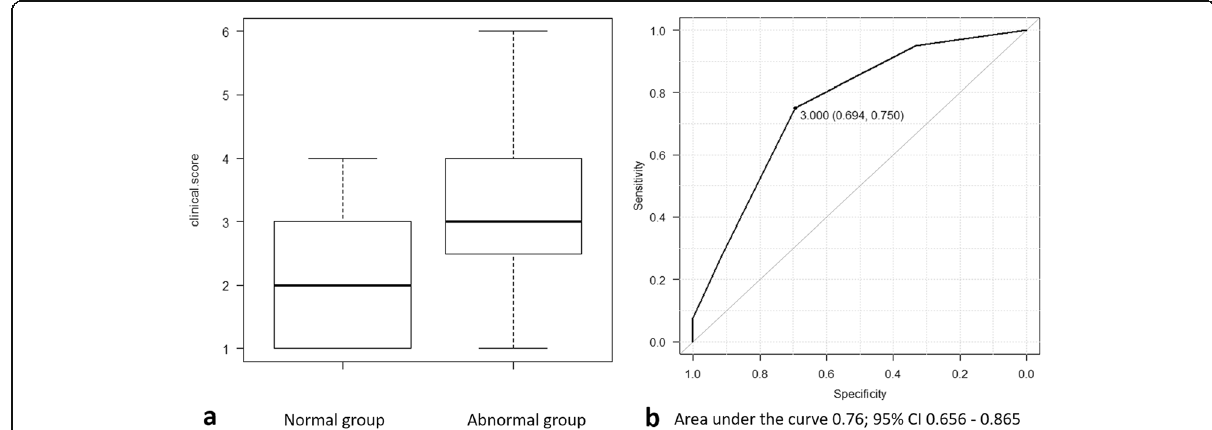
Fig. 7 Clinical score in relation to radiological findings; a ) Box and whisker plot showing that clinical score is higher in patients with abnormal radiological findings (p <.001; b ) Receiver Operating Characteristic (ROC) curves for discrimination between patients with normal and abnormal radiological findings based on the clinical score with calculated cut of value of